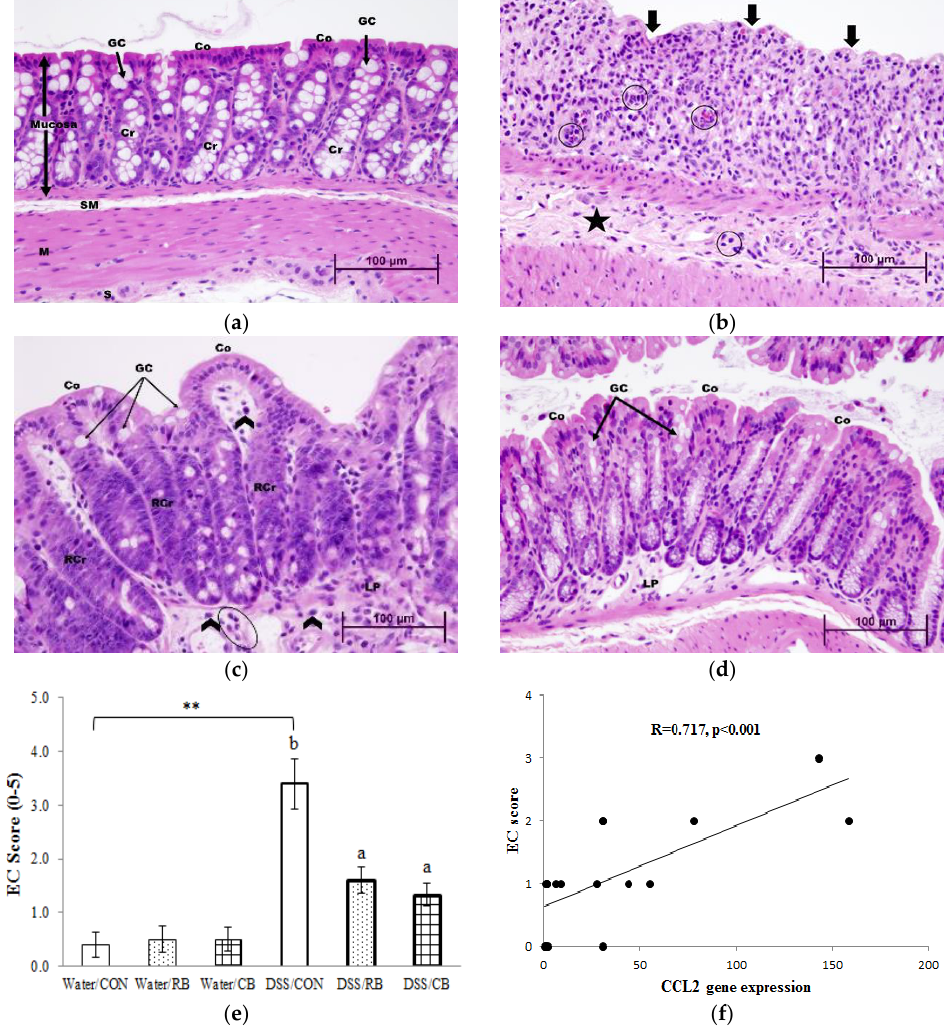
Figure 6. The effect of diet and dextran sulfate sodium (DSS) on histological pathology: ( a – d ) representative microscopic images (40× magnification) of colon sections from Water/CON, DSS/CON, DSS/CB and DSS/RB, respectively; ( e ) erosive/ulcerative colitis (EC) scores; and ( f ) the correlation between mRNA expression of CCL2 and EC score. Abbreviations used in microscopic images are: colonocytes (Co), goblet cells (GC), crypts (Cr), regenerating crypts (RCr), lamina propria (LP), submucosa (SM), and muscularis (M). Highlights are the disappearance of colonocytes (bold arrows), neutrophils (encircled), edematous submucosa (star), and residual histiocytes (arrowheads). Diet groups are tap water and control (Water/CON), tap water and 10% raw broccoli (Water/RB), tap water and 10% lightly cooked broccoli (Water/CB), DSS and control (DSS/CON), DSS and 10% raw broccoli (DSS/RB), and DSS and 10% lightly cooked broccoli (DSS/CB). Data are mean ± SE, n = 6, except for Water/CON, DSS/CON and DSS/RB ( n = 5). *, ** and *** indicate a significant effect of DSS ( p < 0.05, p < 0.01 and p < 0.001, respectively). The presence of letters indicates a significant effect of diet within Water groups or DSS groups ( p < 0.05). Values with the same letter are not different ( p < 0.05).